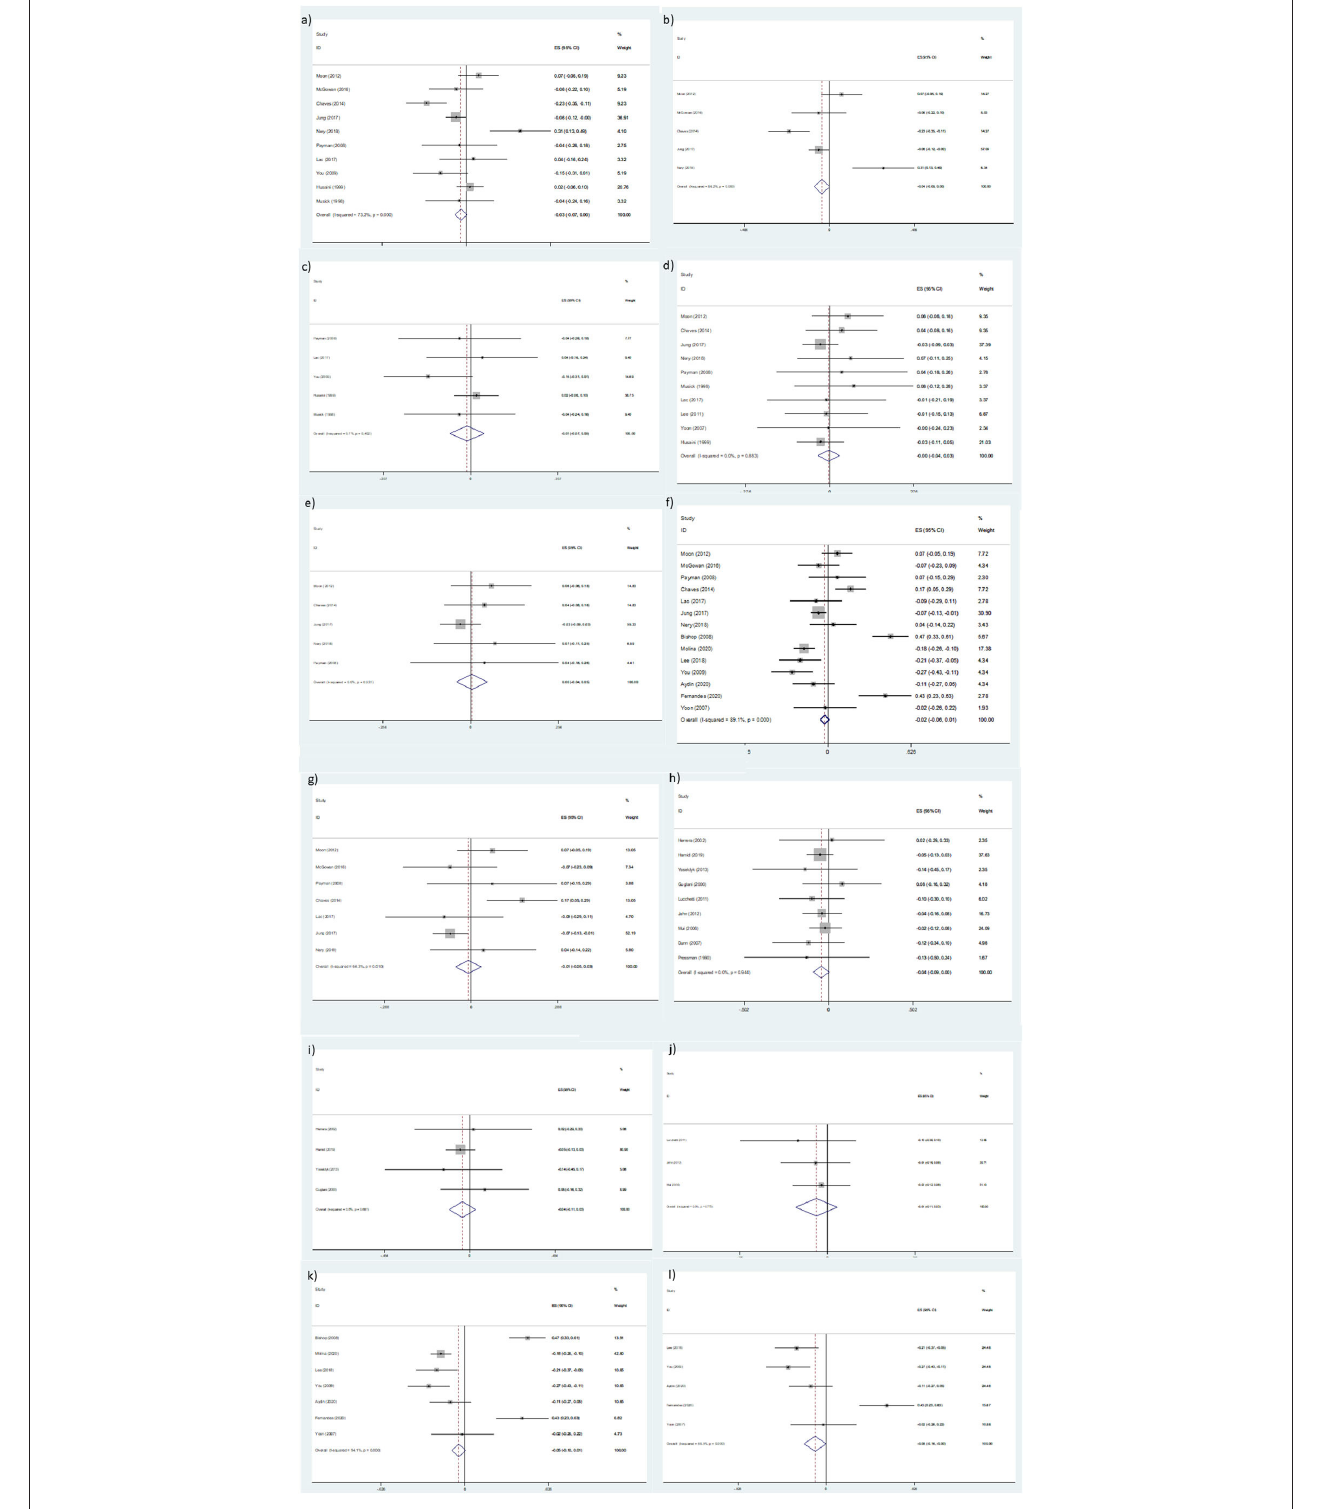
FIGURE 4 | Z-scores for (A) ORA, (B) ORA-based DUREL scores, (C) service attendance, (D) NORA, (E) NORA-based DUREL scores, (F) IR, (G) IR-based DUREL scores, (H) religious, (I) religious, (J) religious devotion, (K) spiritual aspects, and (L) spirituality.